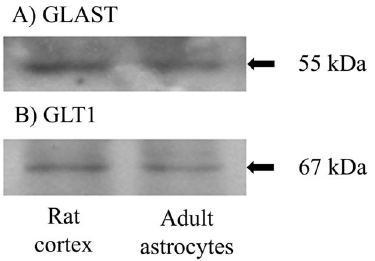
Figure 4. Adult astrocyte cultures express the main glutamate transporters. Representative immunoblot band for ( A ) GLAST and ( B ) GLT1. The left band represents rat cortex homogenate and the right band represents adult astrocytes. N=5 for all immunoblot experiments.